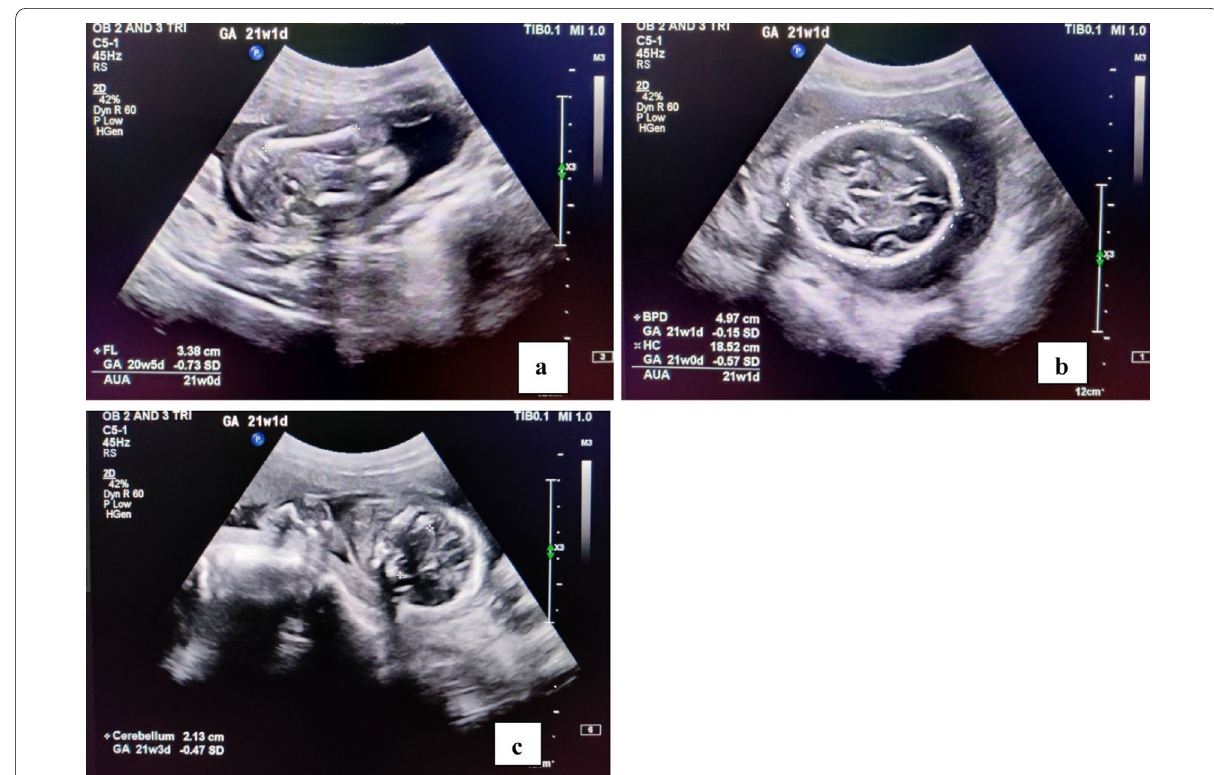
Fig. 2 a–c Trans-abdominal ultrasound image Showing Femur Length, Head circumference, Biparietal diameter and Trans cerebellar diameter corresponding to 21 weeks